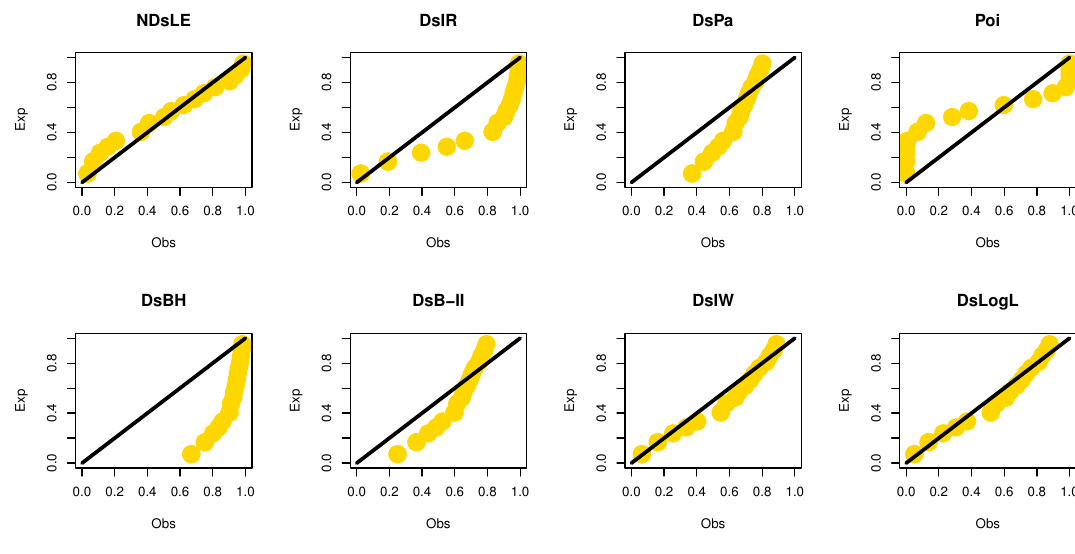
Figure 17. Nonparametric plots for data set IV.